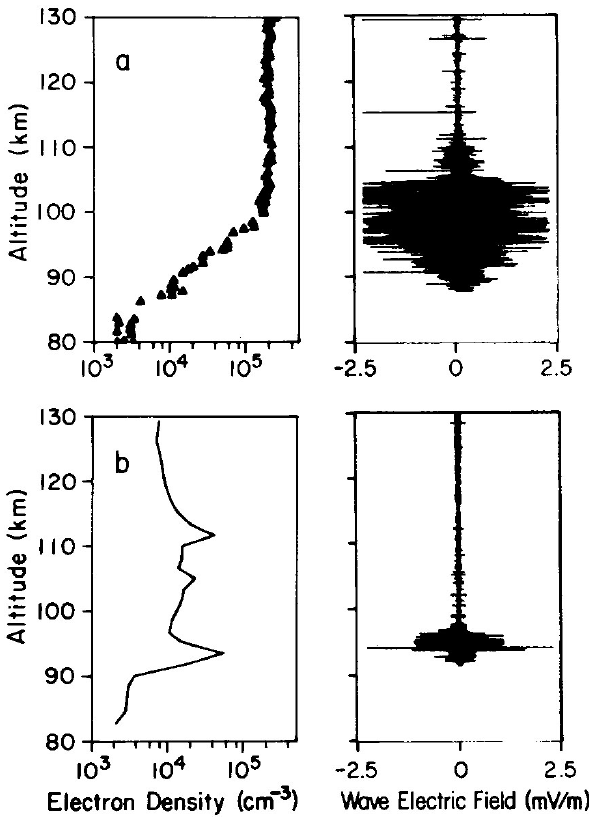
Fig. 4. Daytime (Peru, 1975; panel a ) and nighttime (Kwajalein, 1978; panel b ) rocket observations of density profiles and wave electric fields (from Pfaff et al.,